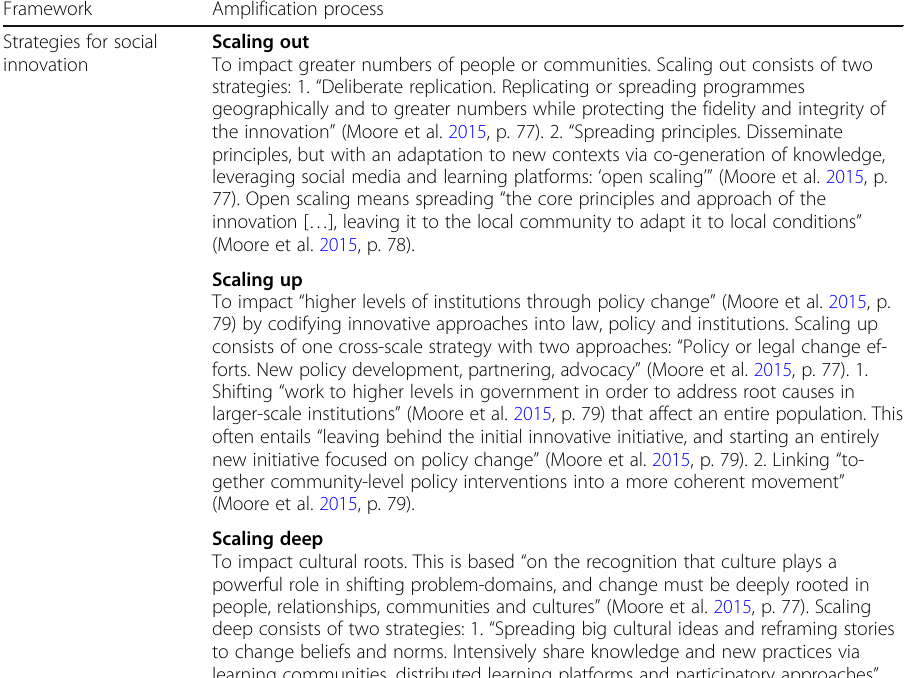
Table 2 Amplification processes from the different frameworks (*Not used in analysis because this process does not focus specifically on increasing